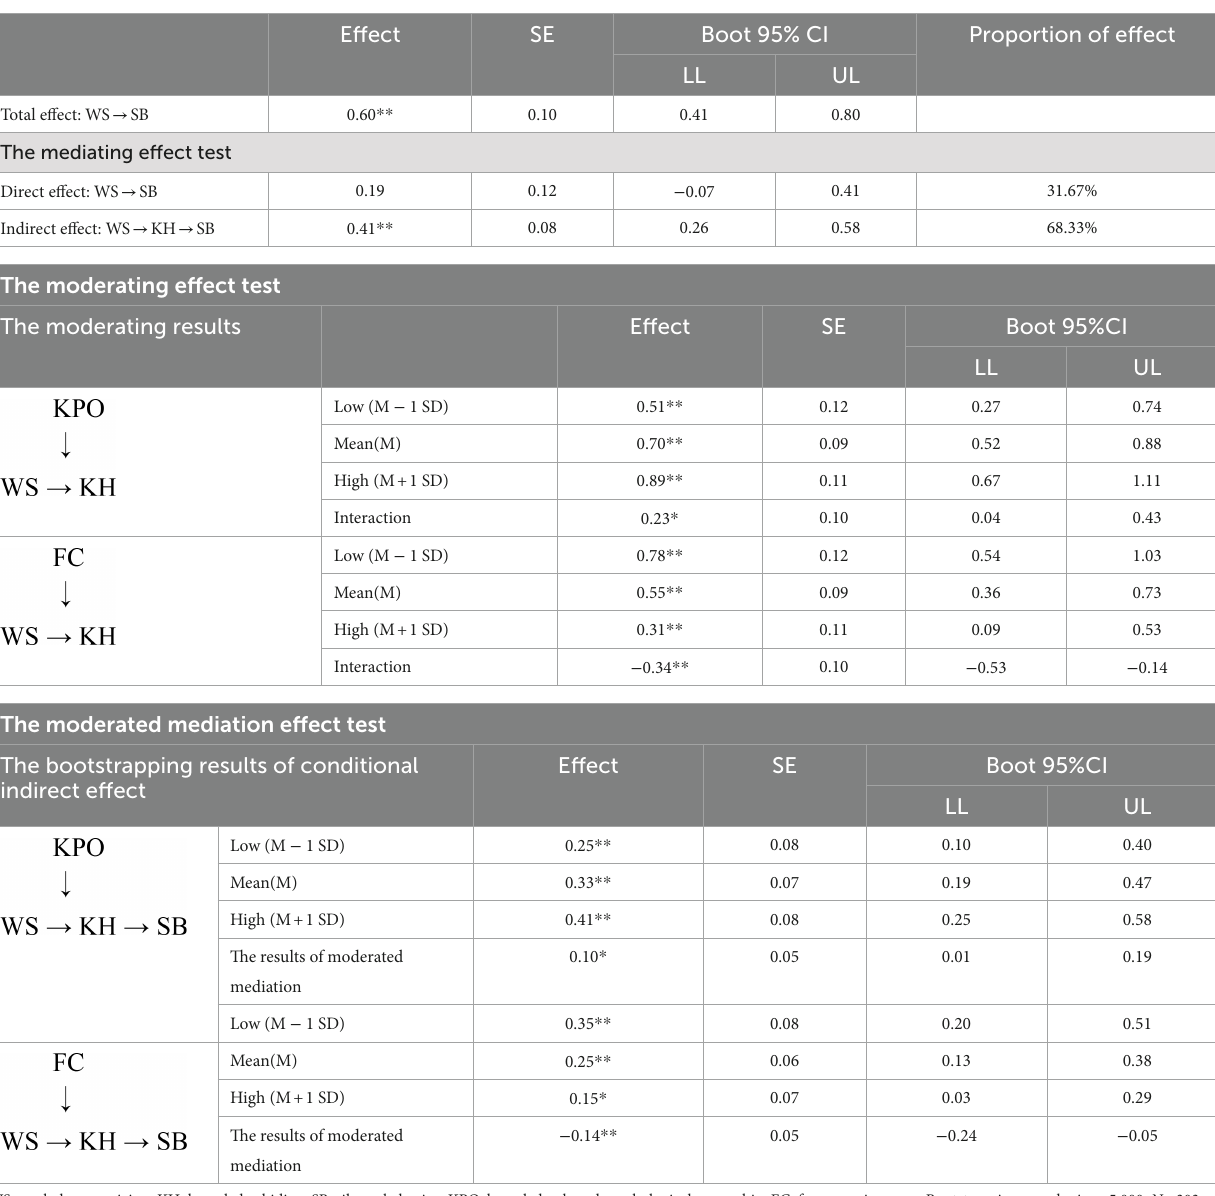
TABLE 3 Conditional process analysis: mediation and moderation